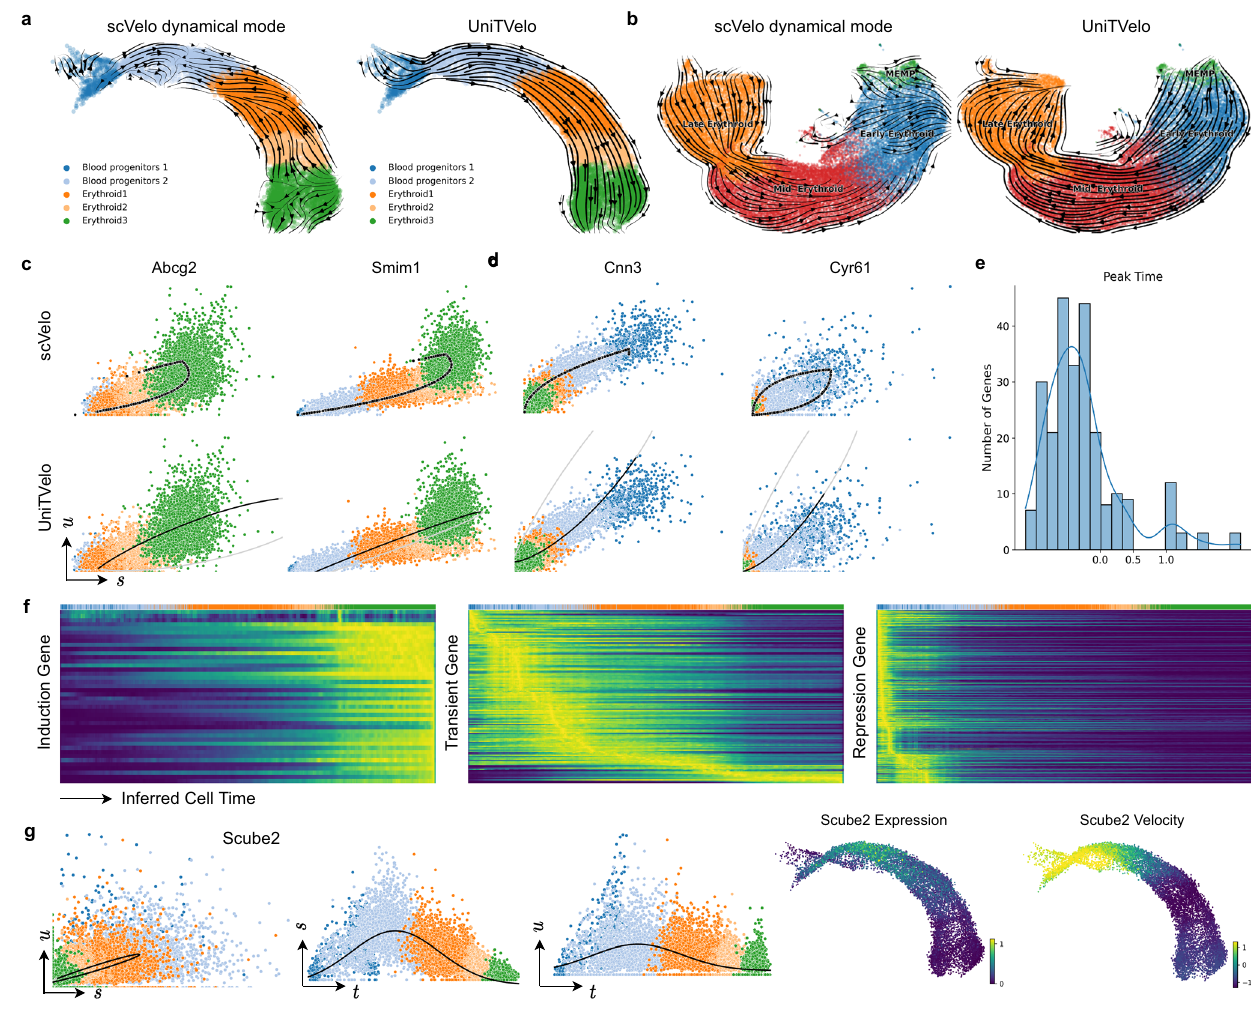
Fig. 2 | UniTVelo correctly identi fi es trajectory of both mouse and human erythroid haematopoiesis lineages. a Velocities derived from scVelo ’ s dynamical mode (left) and UniTVelo (right) ofmouse erythroidlineage. b RNAvelocity isalso tested on a human erythroid dataset starting from progenitor cells, illustrating scVelo ’ s dynamical mode (left) could not fi nd the correct directionality compared with UniTVelo. c , d Four example genes are selected from the mouse erythroid dataset to demonstrate phase portraits depicted from both methods. Abcg2 and Simi1 are induction genes whilst Cnn3 and Cyr61 are repression genes, the former twoarealsoconsideredasMURKgeneswithtranscriptionalboosting.Upperpanel: scVelo.Lowerpanel:UniTVelo,bothgrayandblacklinesarepartofphaseportraits